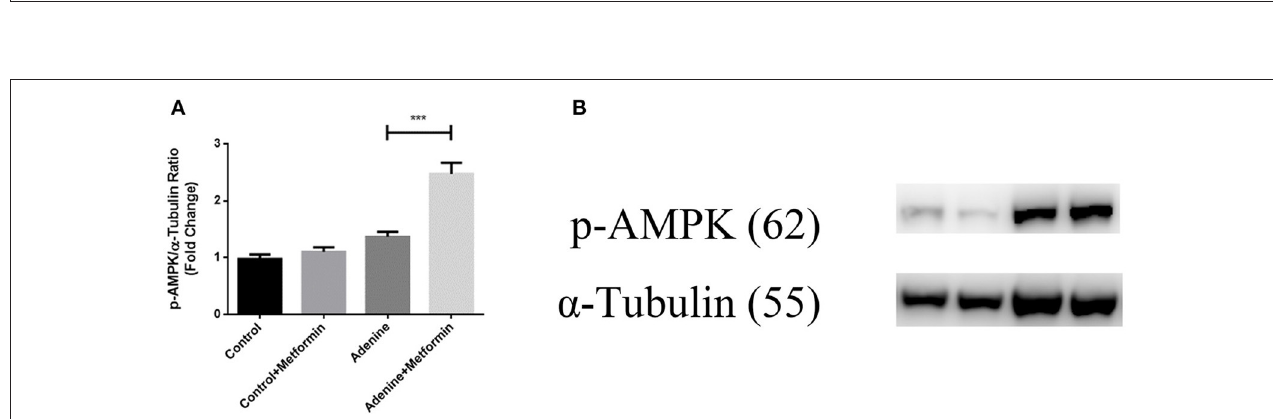
FIGURE 6 | Metformin activated AMPK in a mouse model of adenine-induced renal injury. The result of western blot results showed that metformin activated AMPK (A,B) in metformin-treated mice. Results are presented as mean ± SEM. *** P < 0.001, n = 8.